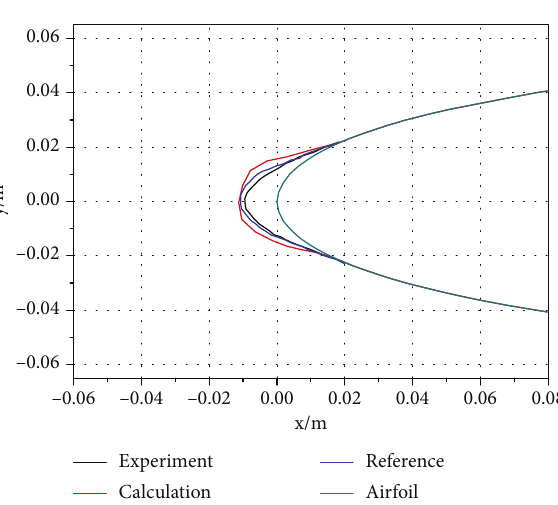
Figure 2: Comparison of ice shapes for condition (1).